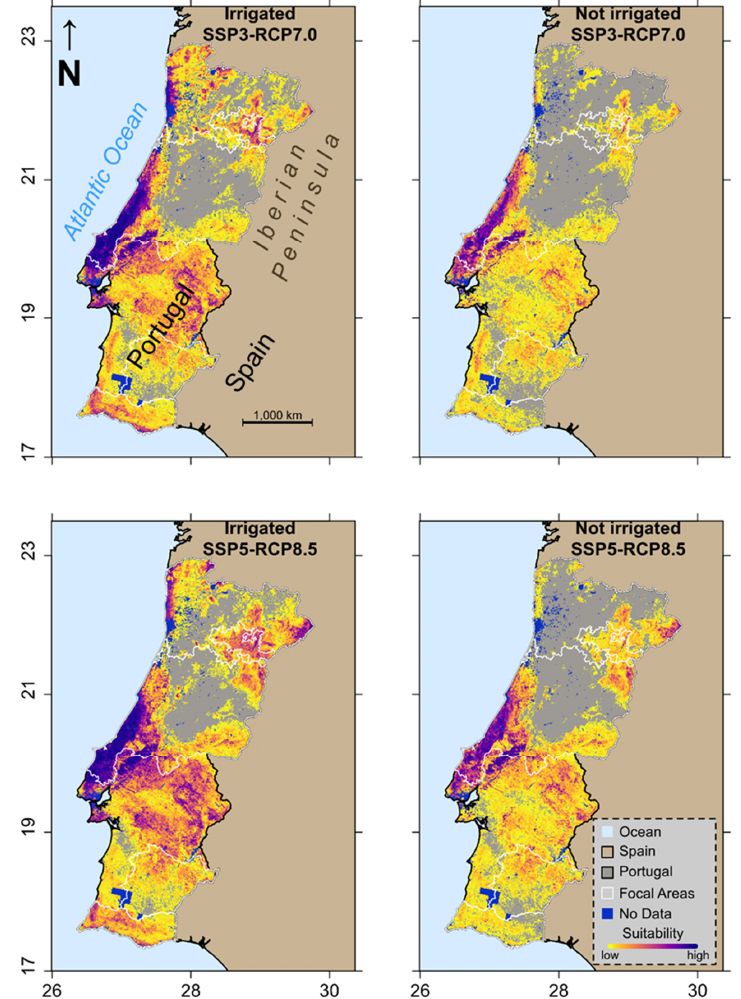
Figure 5. Predictions (EPSG:3035) for the 2071–2100 period; the figure follows the style of Figure 2. ( Left panels ) with irrigation, ( right panels ) without irrigation, ( top panels ) SSP3-7.0 climate trajectory, ( bottom ) SSP5-8.5 climate trajectory.